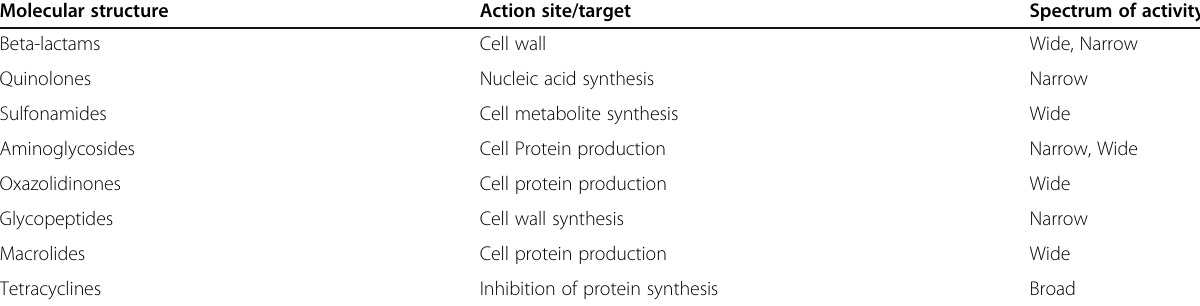
Table 1 Existing groups of antibiotics and their characteristics